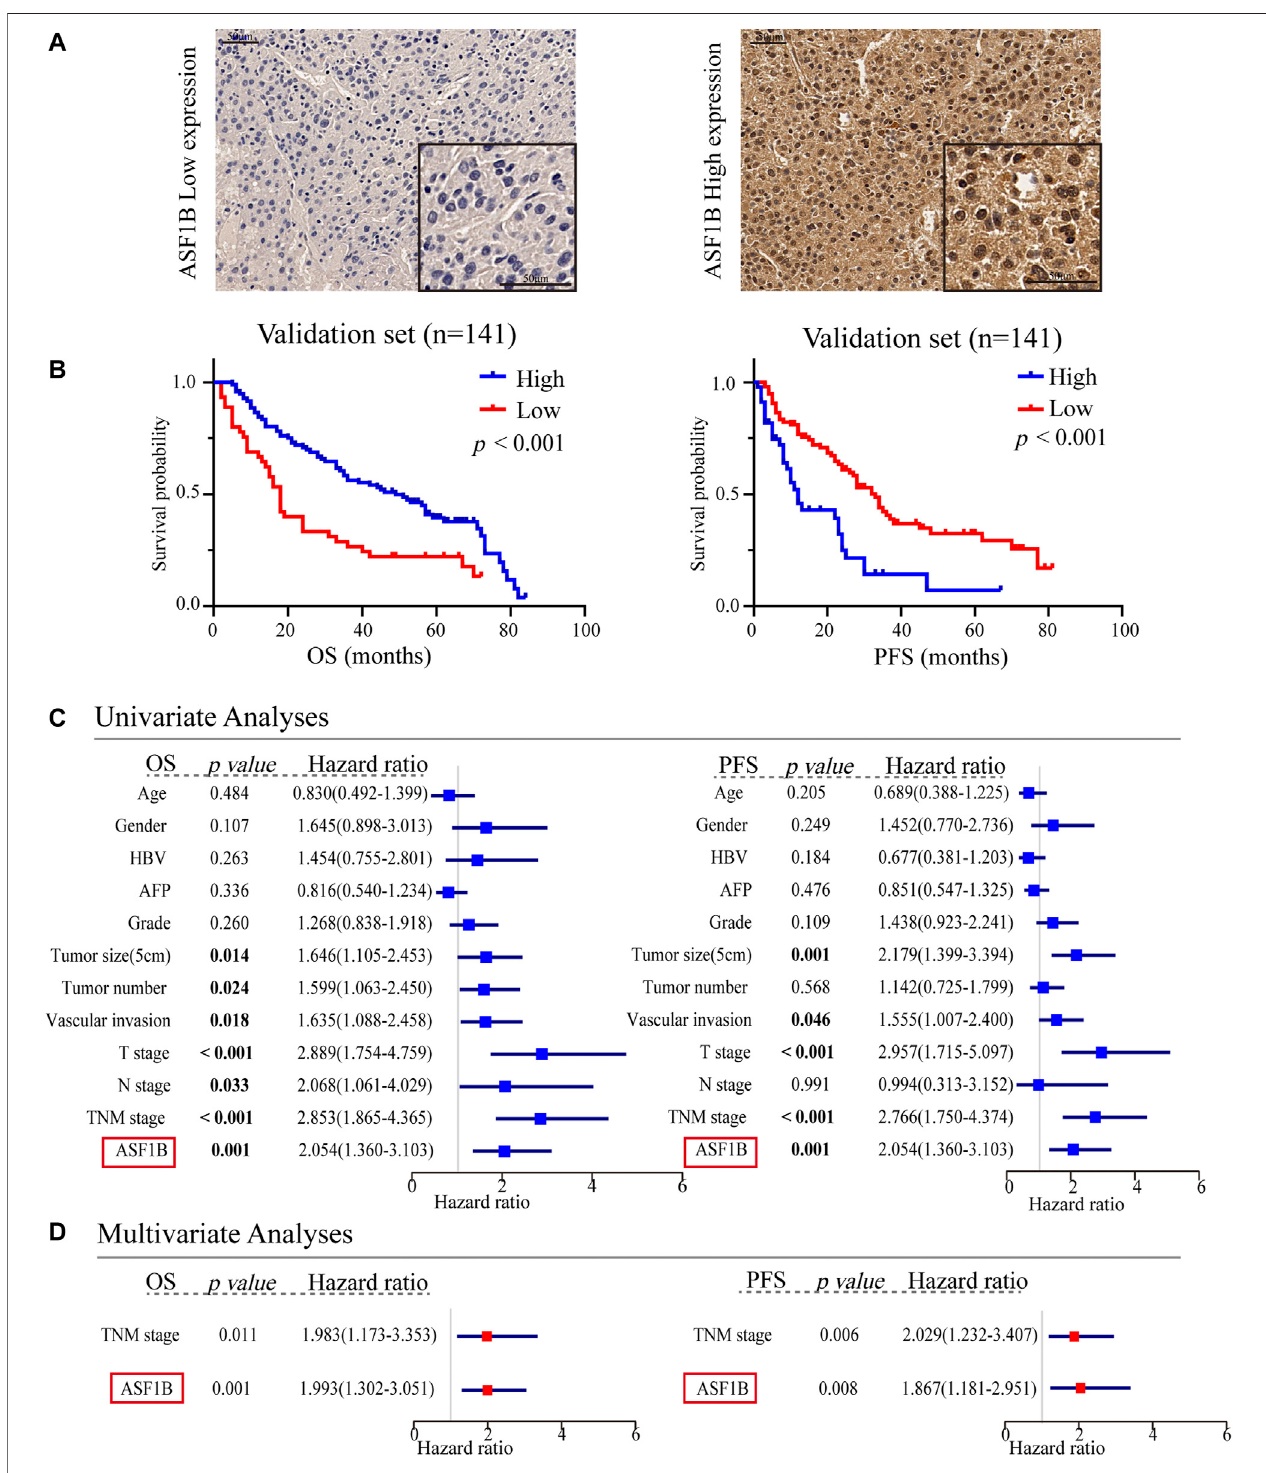
FIGURE 4 | Multifaceted prognostic value of ASF1B in the validation set. (A) Representative microphotographs of ASF1B staining in high and low expression groups; (B) Kaplan-MeierestimatesofOSandPFSaccordingtothelevelofASF1BproteinexpressionthroughIHCinthepatientswithHCCinourcenter.Validationset, OS ( p < 0.001), PFS ( p < 0.001); (C) Univariate Cox regression analyses of OS and PFS related factors among our center HCC cases; (D) Multivariate Cox regression analyses of OS and PFS related factors among our center HCC cases.